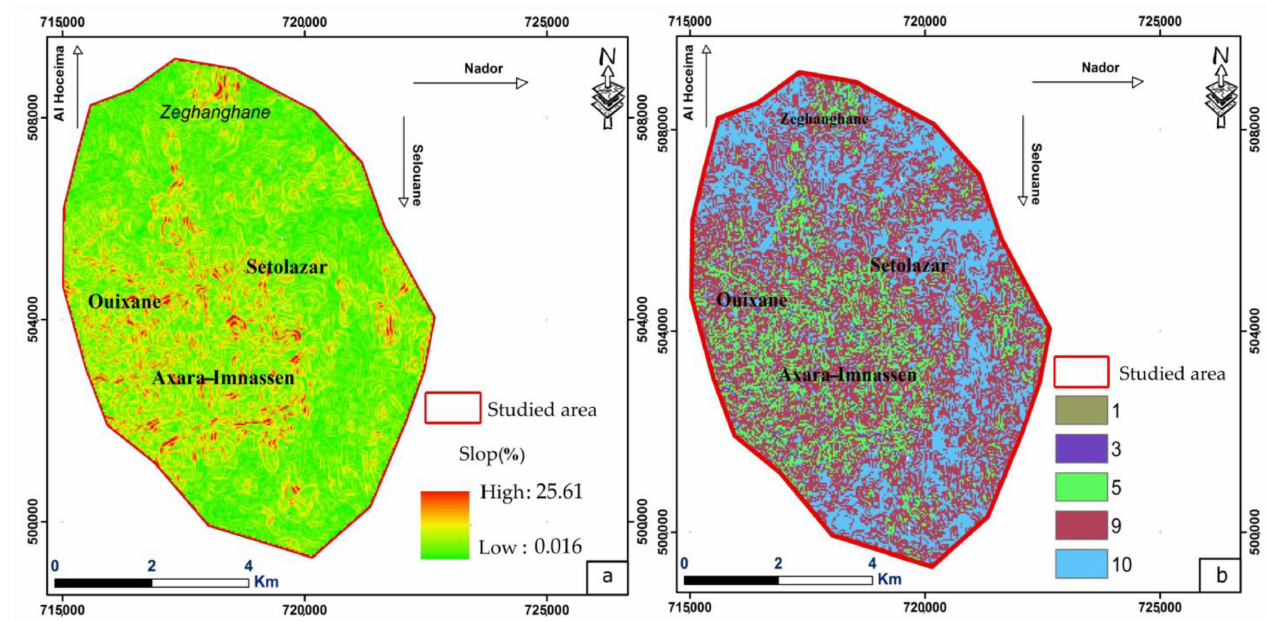
Figure 8. ( a ) Slope map (%) allowing the distinction of the classes of slope indicated in ( b